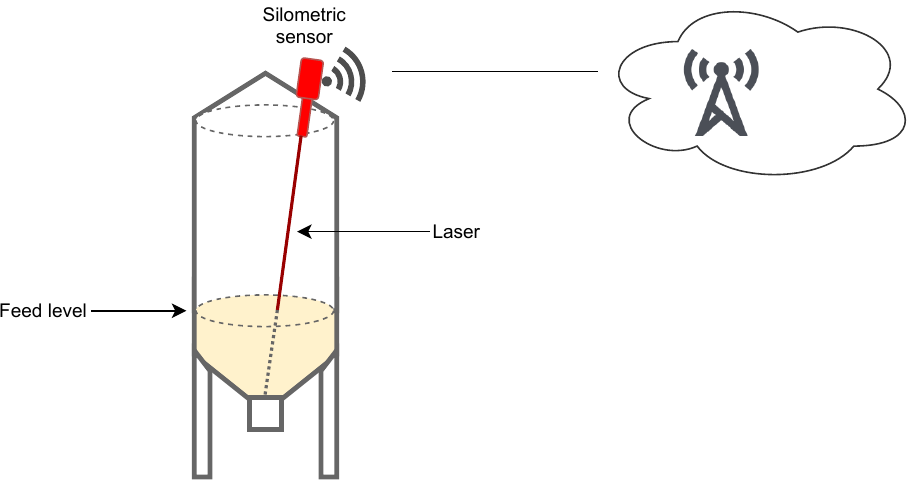
Figure 5. Diagram of the spatial distribution of the sensor in the silo. Technical details can be found on the manufacturer web page [38].